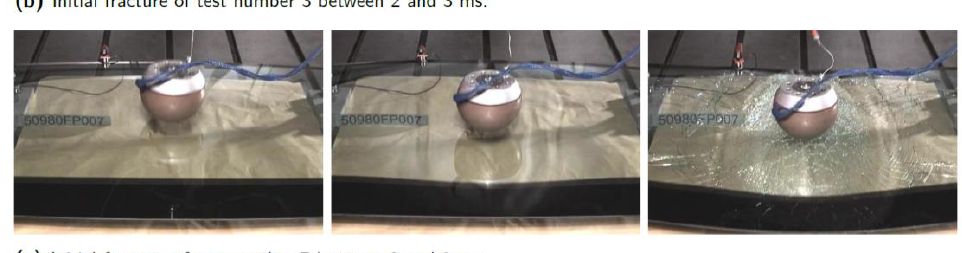
Figure 1. Comparison of head impacts on three windshields (Audi A3), cf. [11].